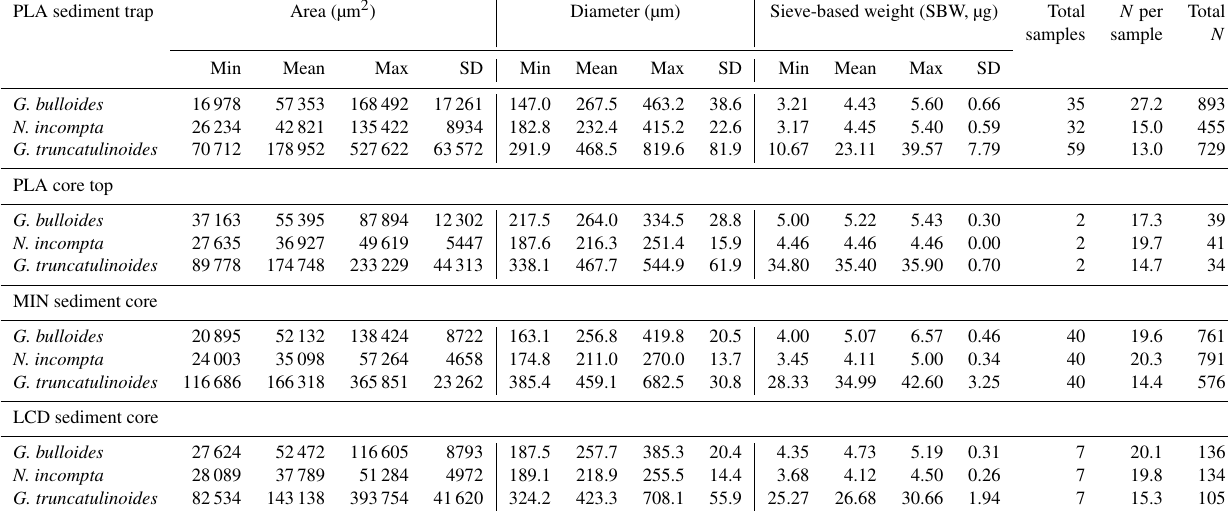
Table 2. Minimum, mean, maximum, and standard deviation values of shell area, diameter, and SBW for G. bulloides, N. incompta , and G. truncatulinoides at all studied sites. The last three columns show the number of samples, the mean number ( N ) of individuals analysed per sample, and the total number of individuals measured for each